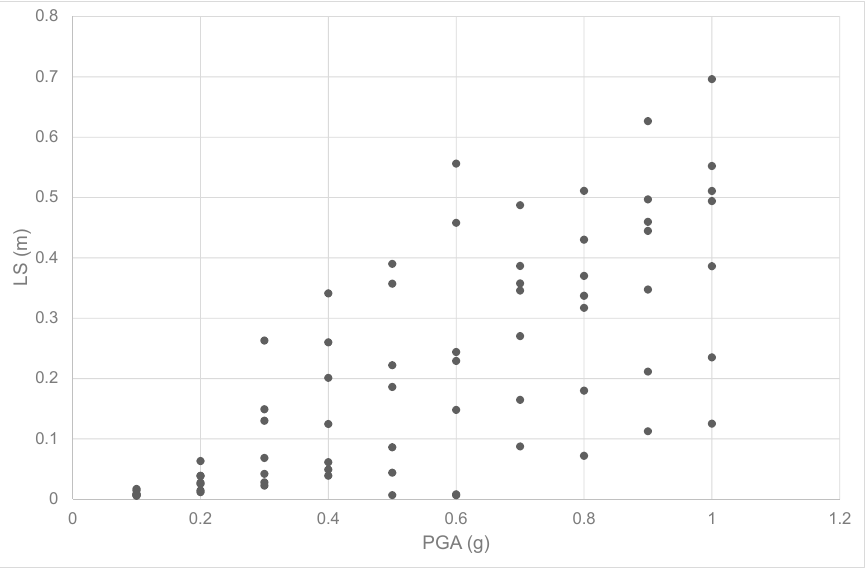
Figure 6. Free field (F: maximum lateral spread (LS) and settlement (ST) vs. soil depth (input motion 2, 100%).